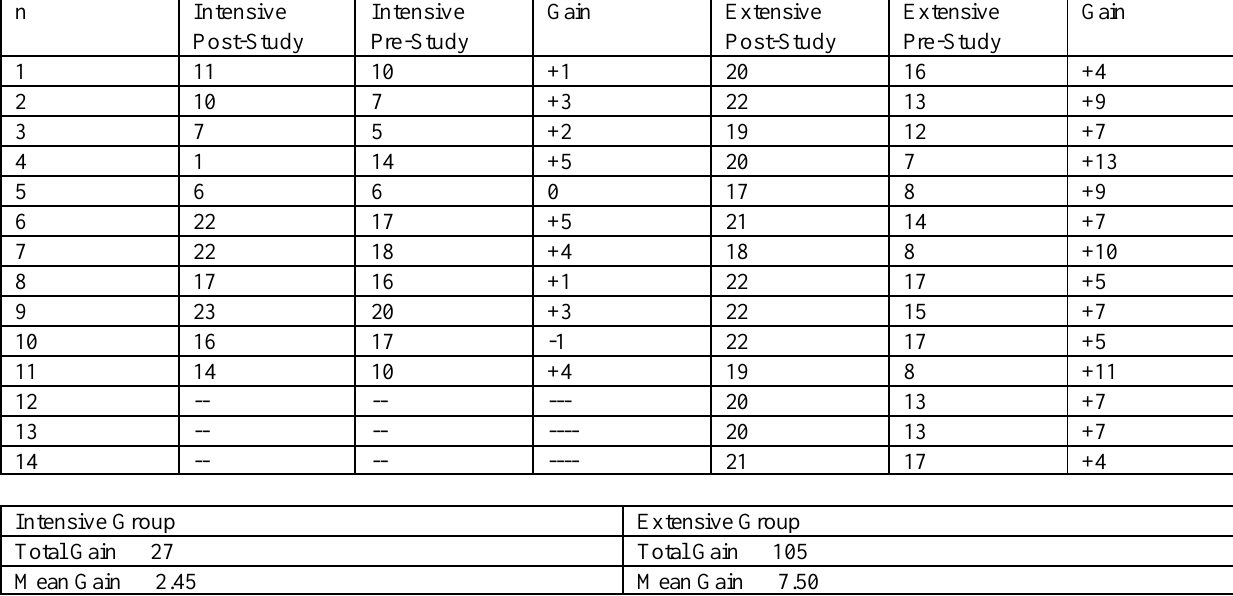
Table 4.12 Reading Comprehension – Analysis of Gains Modified Cloze Test n